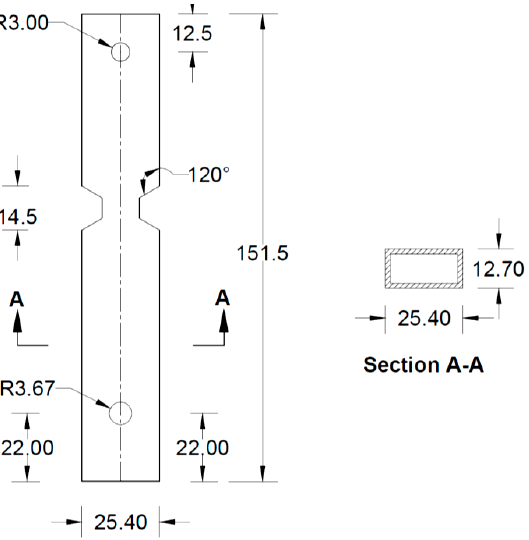
Figure 13. Details of Middle bar (all dimensions are in mm, HSS section).